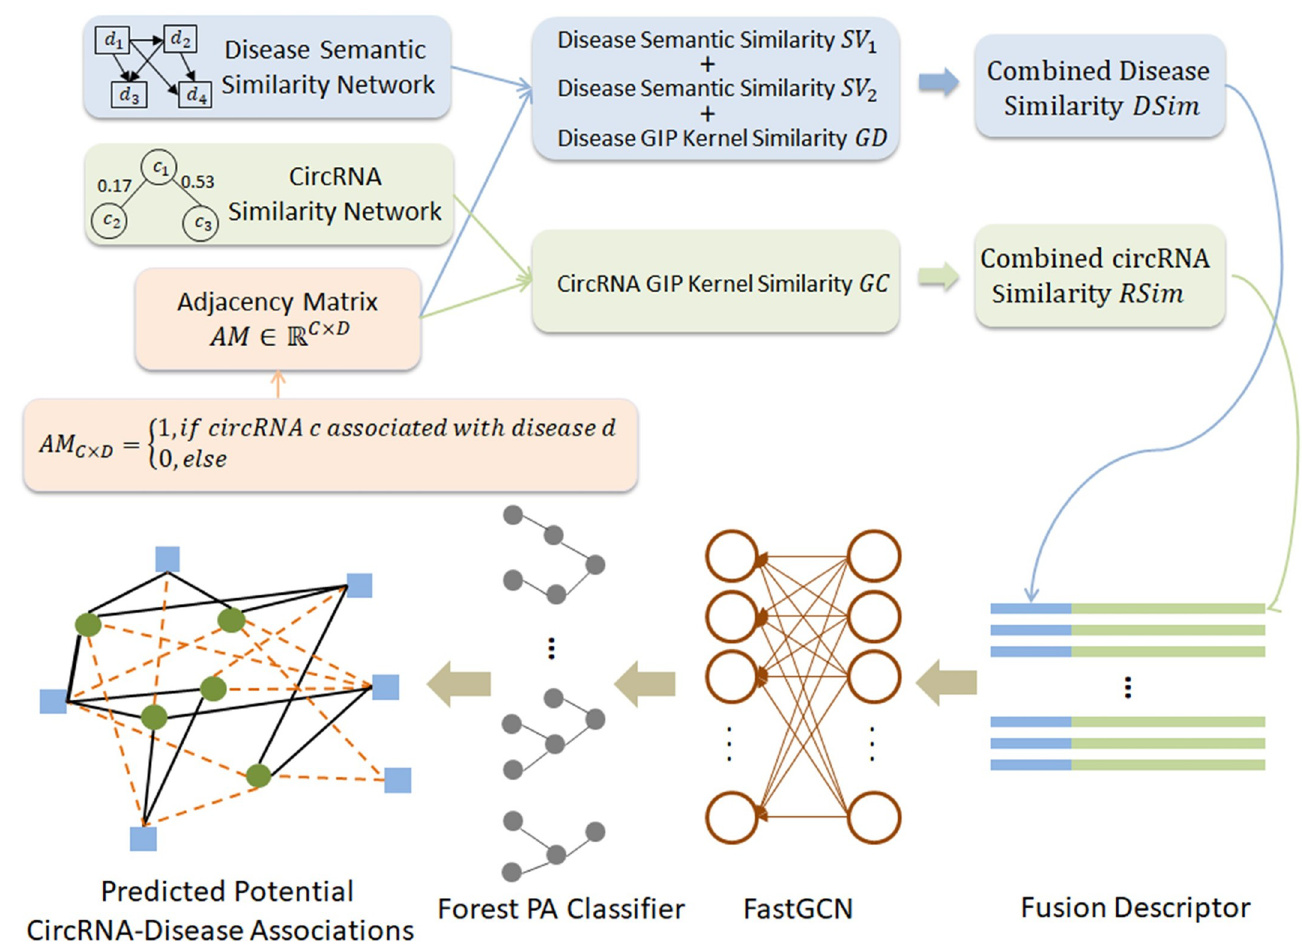
Fig 6. The framework of GCNCDA to predict potential circRNA-disease associations.